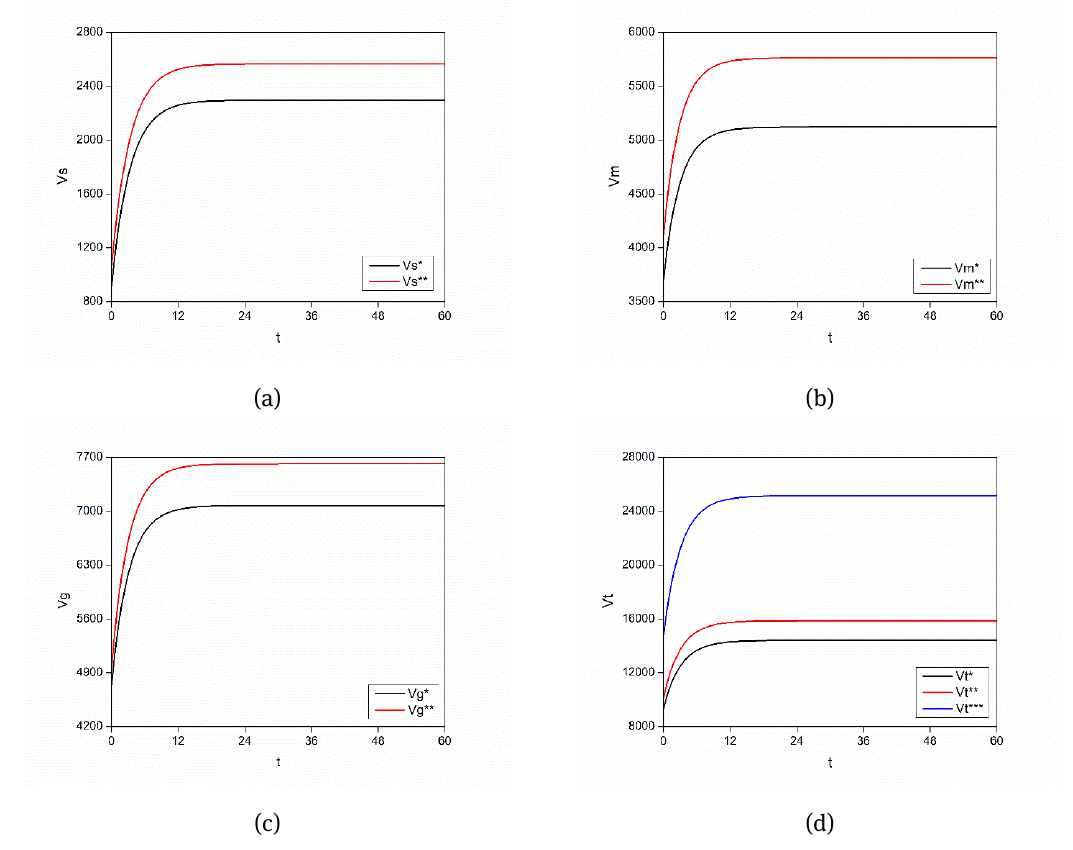
Figure 3: Change trend in the benefits of supplier, manufacturer and